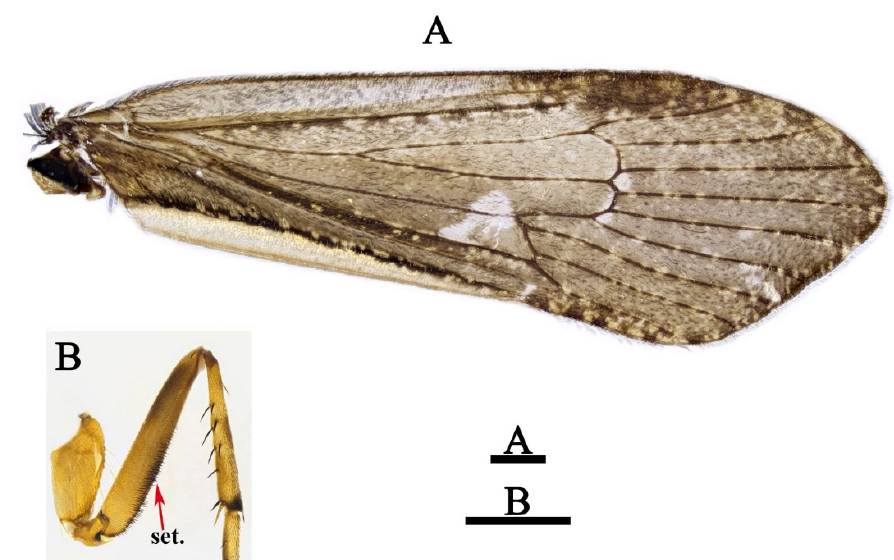
Figure 2. Limnephilus deqianensis n. sp. , male. ( A ) Forewing; ( B ) forefemur. Abbreviations: set. = setal brush. Scale bars: 1 mm.